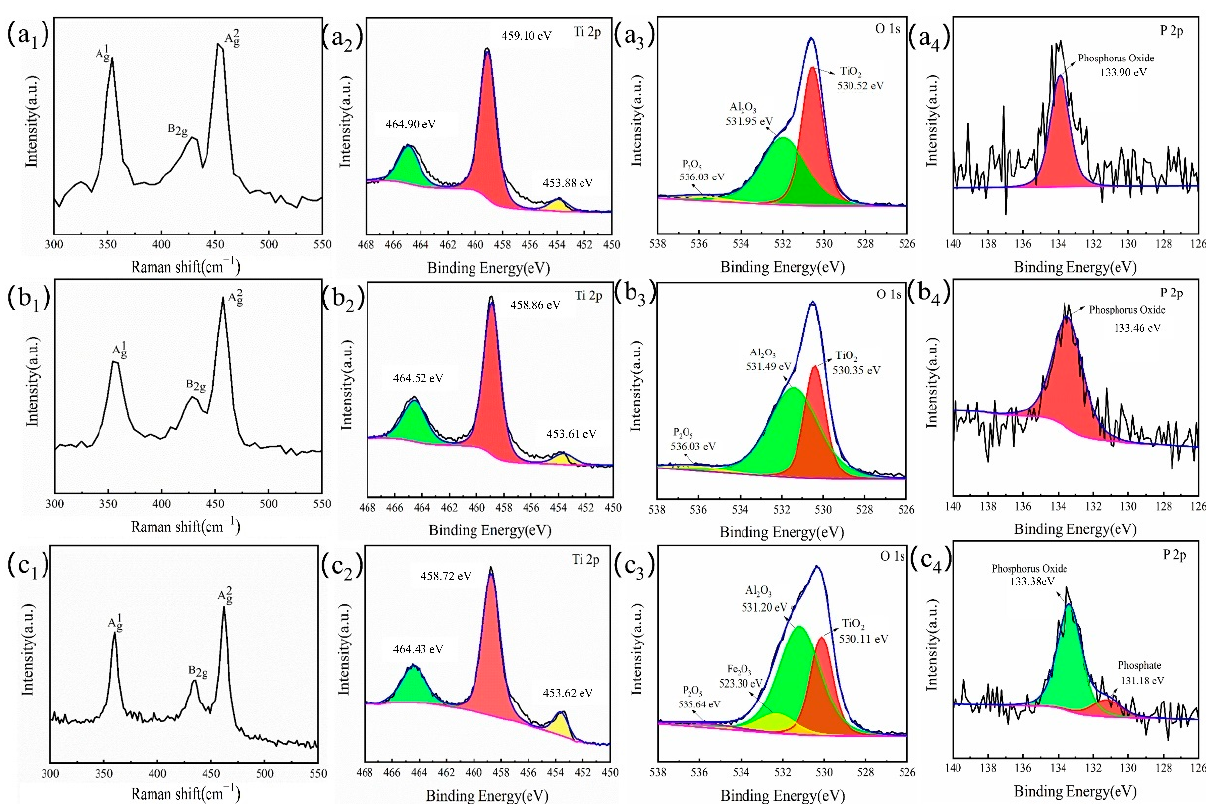
Figure 11. Raman and XPS of the wear scar surface lubricated by the 0.075 wt.% L-BP ( a 1 – a 4 ), M-BP ( b 1 – b 4 ), and BPQDs ( c 1 – c 4 ) lubrication additives (10 N, 150 r/min, 30 min).